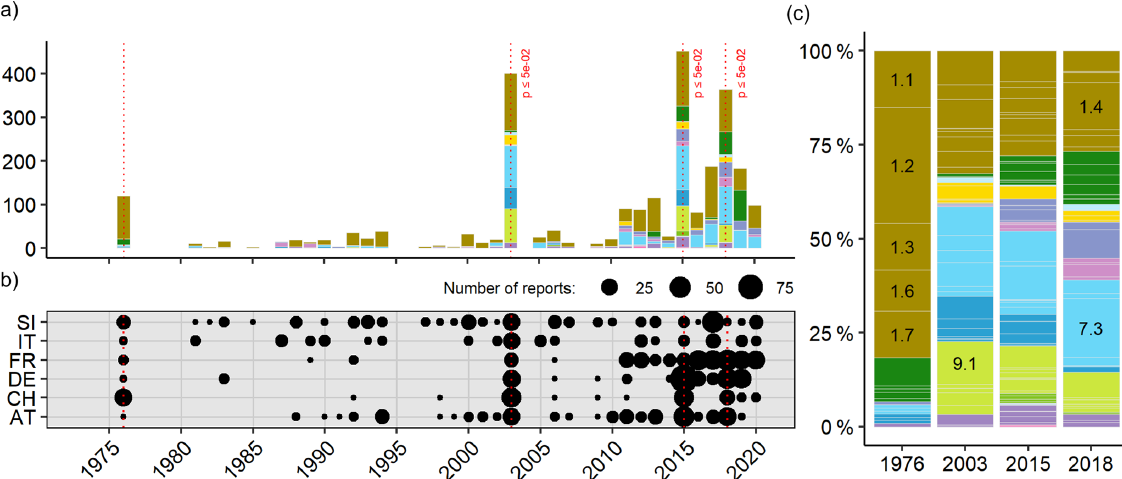
Figure 3. Reported impact categories between 1975 and 2020. (a) Number of reports per year and identified drought events (red dotted line) with significantly different years labelled. (b) Number of all reports per country and year. (c) Fraction of impact categories (coloured) and their subtypes (faint lines) for drought events. Subtypes with a fraction ≥ 10% per region are labelled. For an explanation of the colours,